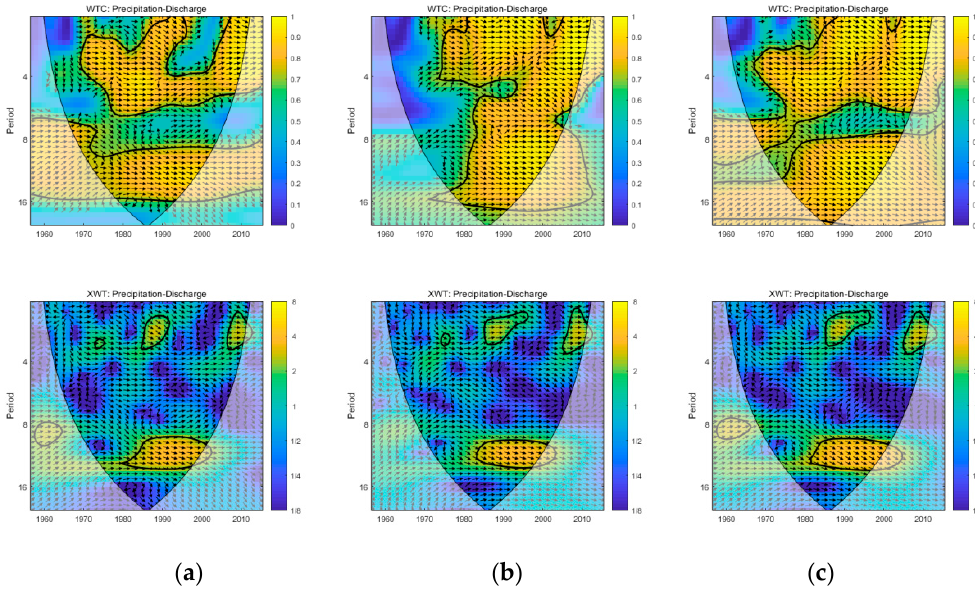
Figure 12. Wavelet coherence and cross wavelet transform of discharge of three hydrological stations 10. ( a ) Nugesha station; ( b ) Nuxia station; ( c ) Yangcun station.